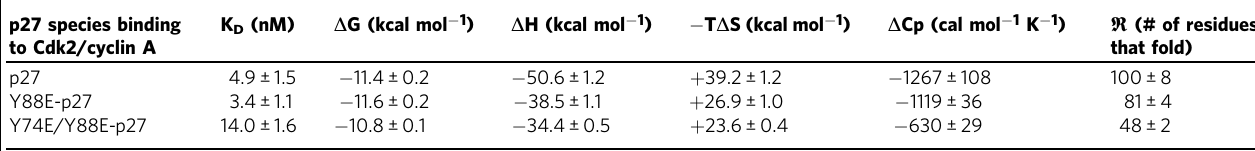
Table 1 Thermodynamic parameters for the binding of p27, Y88E-p27, and Y74E/Y88E-p27 to Cdk2/cyclin A determined by ITC p27 species binding K D to Cdk2/cyclin A